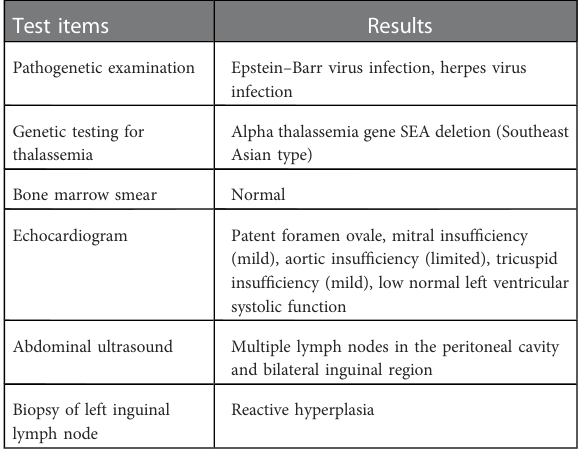
TABLE 2 Other examination results at admission. Test